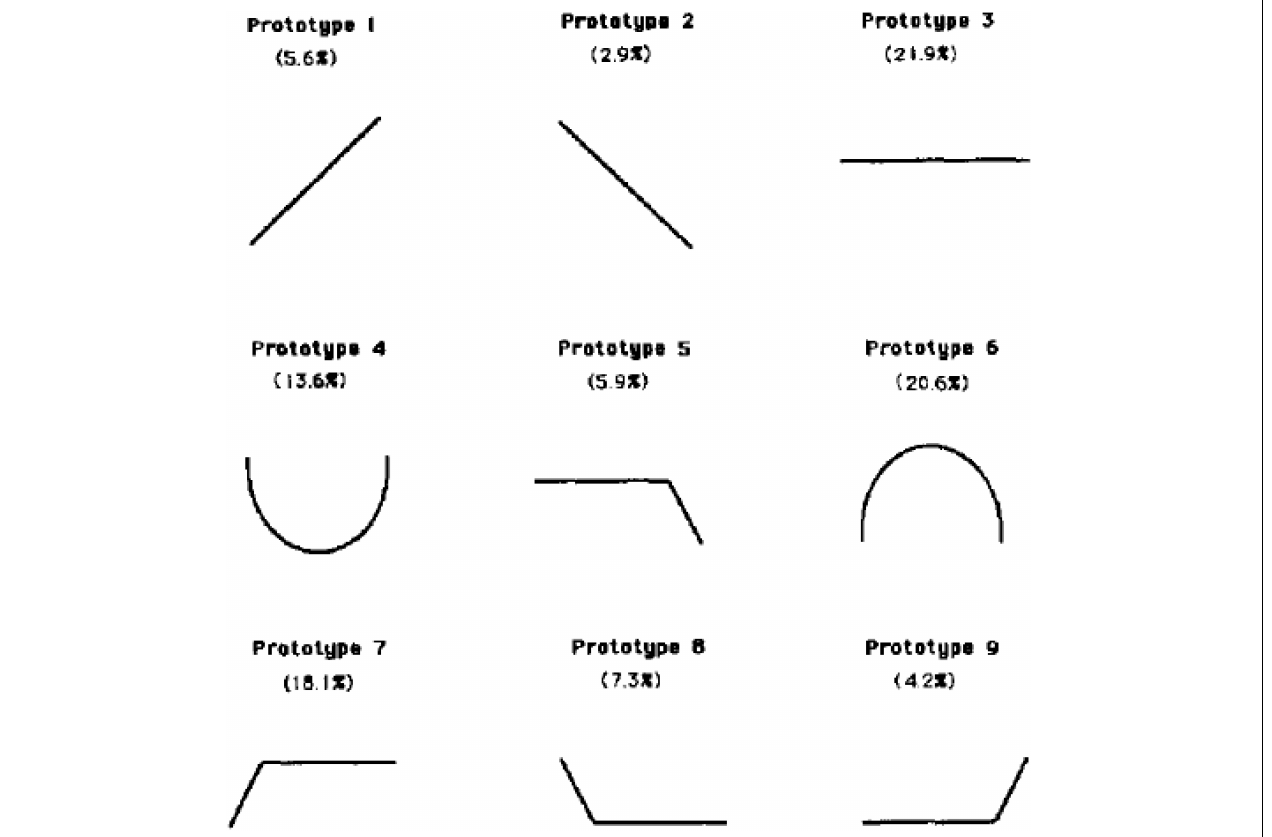
FIGURE 1 | Images representing different implicit theories of developmental change. Image taken from Figure 1 of Ross (1989). Participants saw each line with a description. Patterns referred to here as (in numerical order): increasing, decreasing, flat, U, elderly decline, parabolic, plateau, floor, elderly